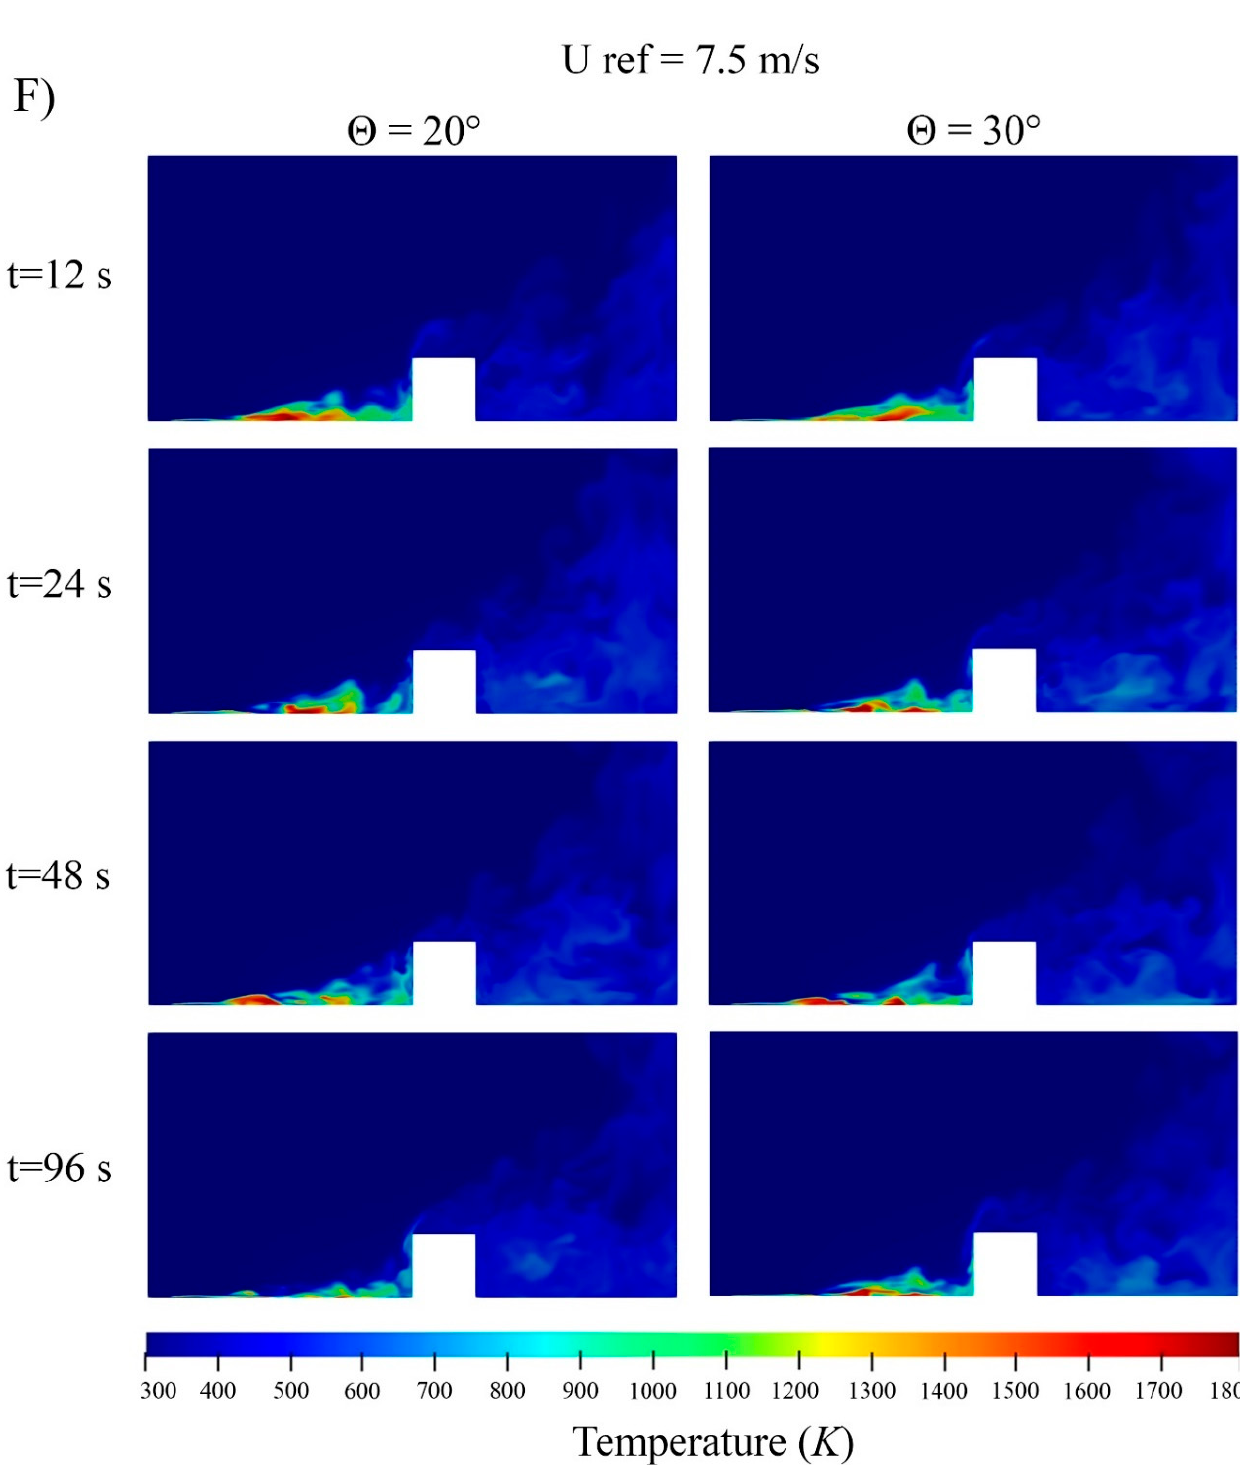
Figure 3. Temperature distribution for the reference velocity ( A , B ) U ref = 4.5, ( C , D ) U ref = 6, ( E , F ) U ref = 7.5 m/s in various terrain slope angles.